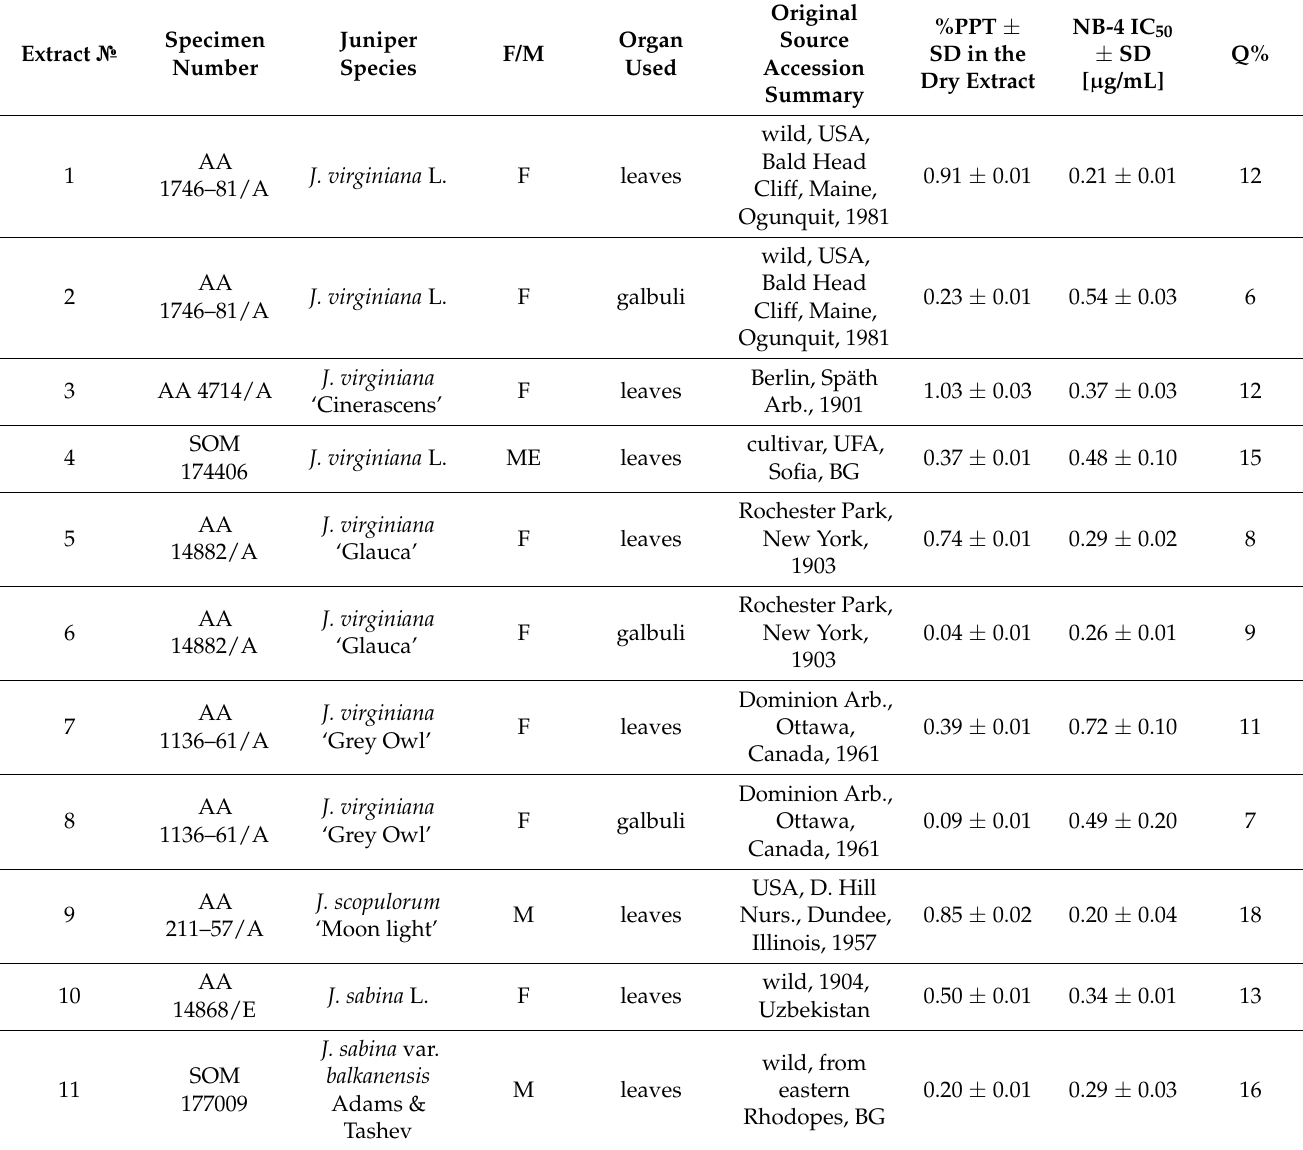
Table 1. Original source accession summary of junipers of different origins and comparison of the podophyllotoxin content, antiproliferative activity in NB-4 cells, and yields of the juniper extracts.